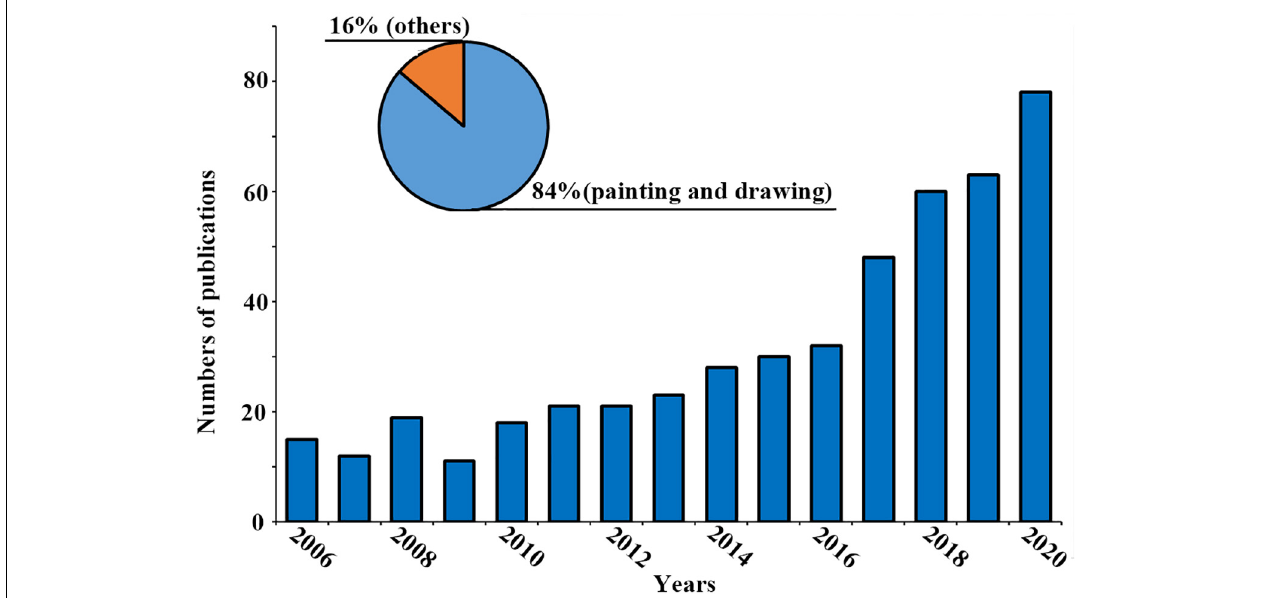
FIGURE 1 | Number of publications about art